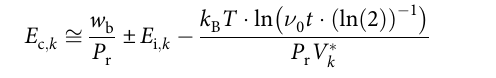
using an equation constructed by Vopsaroiu et al. 39,40 : corresponding coercive fi eld consequently changes to: